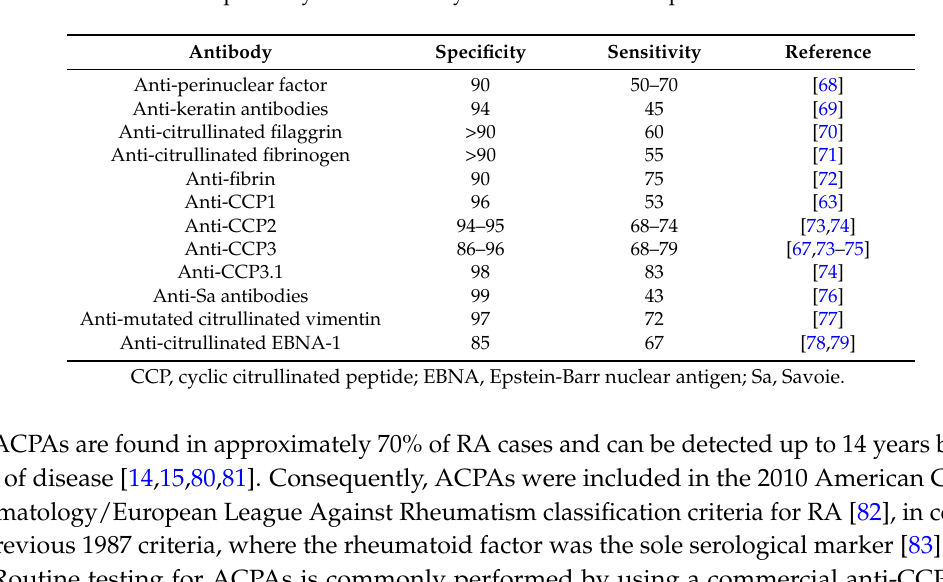
Table 2. Specificity and sensitivity of anti-citrullinated protein